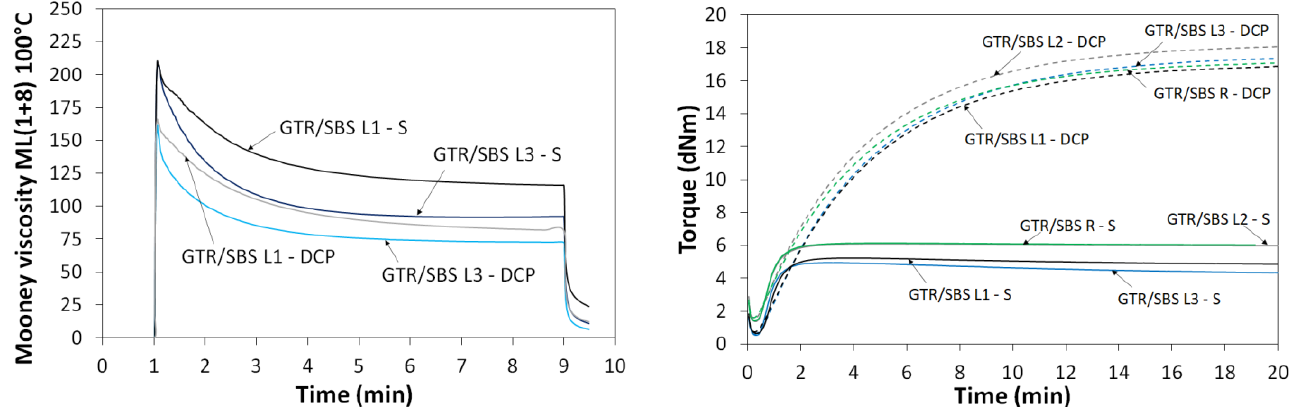
Figure 1. Mooney viscosity and curing characteristics (performed at 170 °C) of the studied GTR/SBS blends . Table 2. Curing characteristics of the studied samples performed at 170 °C.